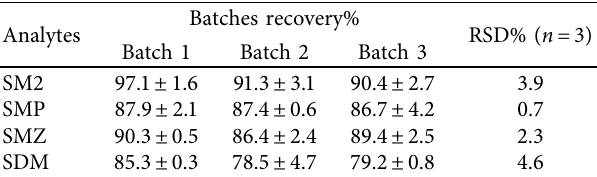
Figure 7: Effects of the elution types (a), eluent volumes (b), and elution times (c) on the desorption efficiency of SAs. The concentrations of analytes were 5.0 μ g · L − 1 . Table 2: The precision between